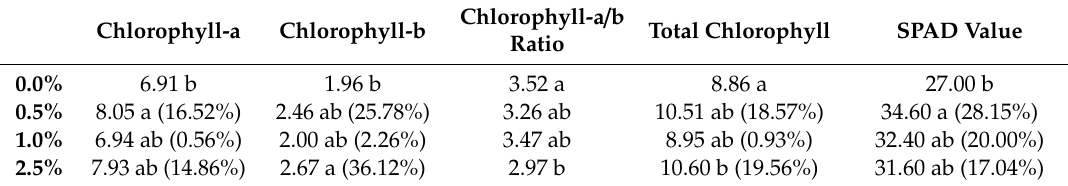
Table 1. Content of chlorophyll in sweet basil leaves (mg g − 1 ) and their relative changes (%) compared to the control plants (0.0%) ( n = 9).